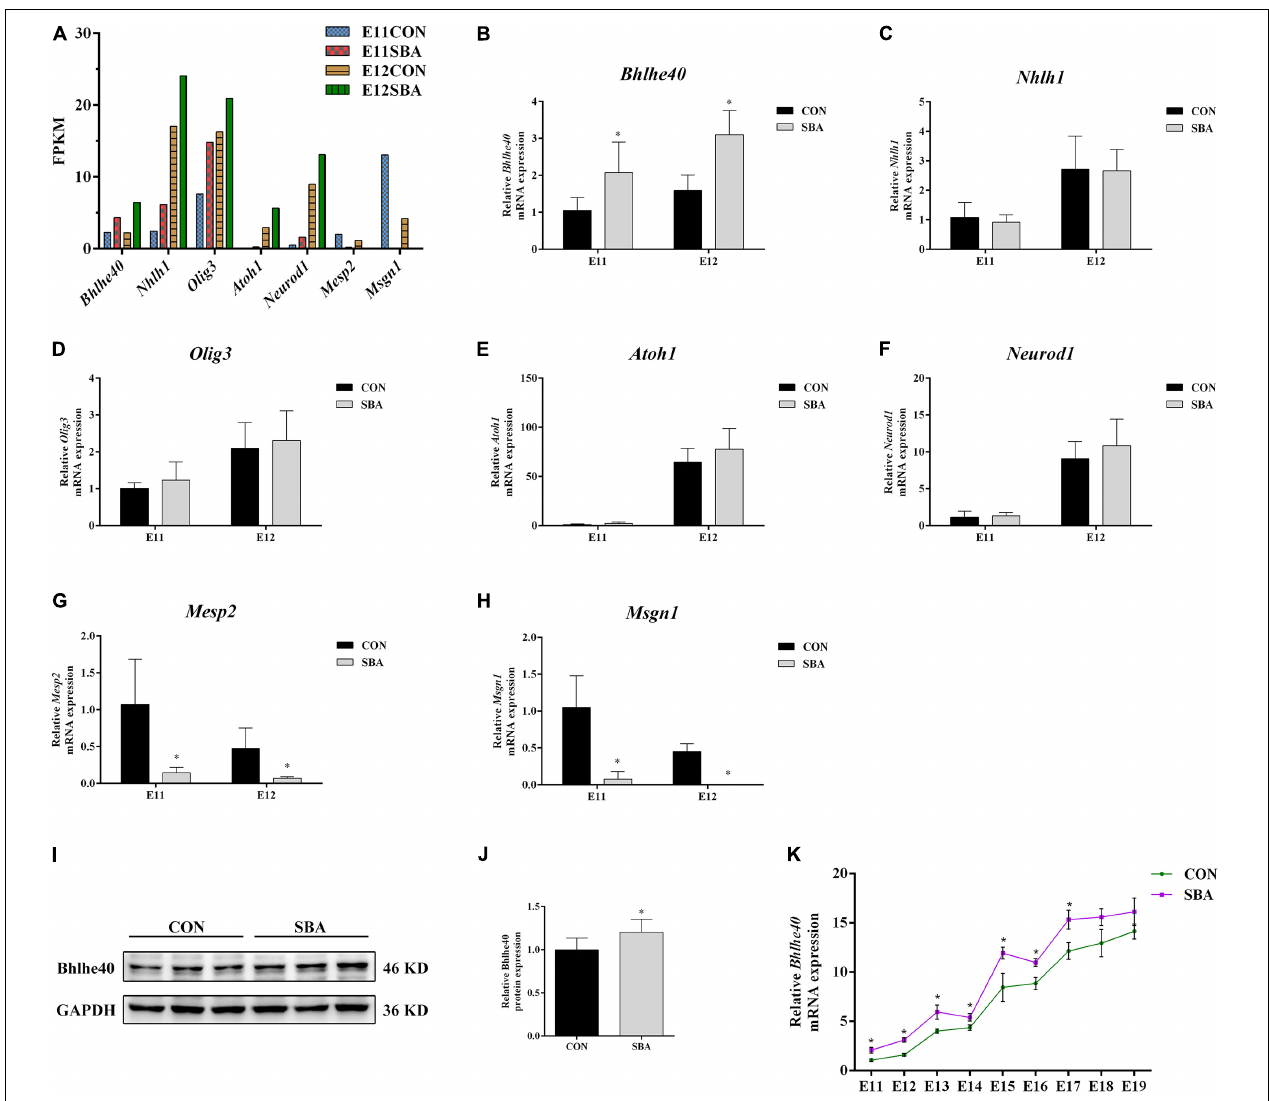
FIGURE 5 | Expression of bHLH transcription factors in spinal cords of rat embryos with SBA-induced ATRA. (A) Average fragments per kilobase of transcript per million fragments mapped values of transcription factors in SBA rat embryos ( n = 3). (B–H) Relative mRNA expression of Bhlhe40 , Atoh1 , Neurod1 , Nhlh1 , Olig3 , Mesp2 , and Msgn1 in rat embryonic spinal cord tissues in the CON and SBA groups on E11 and E12 as assessed by RT-qPCR ( n = 6). Results are expressed as the mean ± SD. ∗ p < 0.05 vs. control group. (I) Western blot of Bhlhe40 expression. (J) Quantitation of Bhlhe40 expression ( n = 6). Results are expressed as the mean ± SD. ∗ p < 0.05 vs. control group. (K) Relative Bhlhe40 mRNA expression in rat embryonic spinal cord tissues of the CON and SBA groups from E11 to E19 as assessed by RT-qPCR ( n = 5). Results are expressed as the mean ± SD. ∗ p < 0.05 vs. control